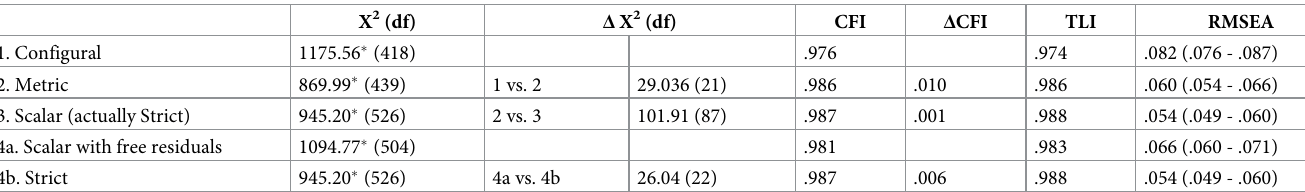
Table 4. Fit indices for models testing various levels of measurement